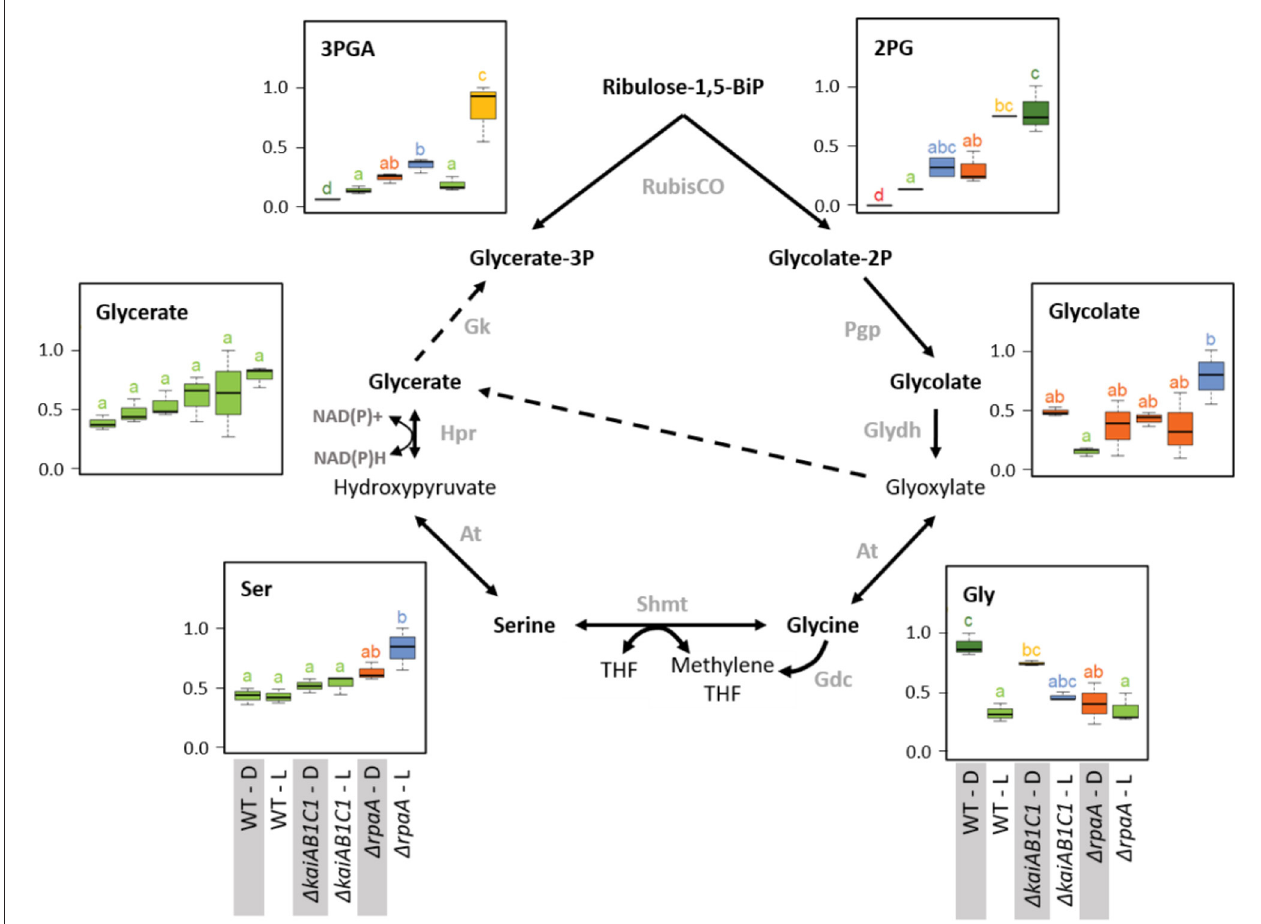
FIGURE 7 | Photorespiration. Box plots showing the maximum normalized relative changes in the metabolite concentrations and Tukey test results ( P < 0.05, n = 3). Metabolite levels that significantly differ are indicated by lowercase letters and color coding. Note the moderate and strong increases in the RubisCO products 3PGA and 2PG in the 1 kaiAB1C1 mutant and the 1 rpaA mutant, respectively. High 2PG accumulation in the 1 rpaA mutant continues in the D phase and is associated with glycolate accumulation in the L phase. Serine and glycine respond inversely to RpaA deficiency. Glycine fails to accumulate in the D, while serine accumulates in the L. Dashed arrows indicate multiple reaction steps. Relevant enzymes and complexes include (gray) glycolate-2P phosphatase (Pgp), glycolate dehydrogenase (Glydh), aminotransferase (At), glycine decarboxylase complex (Gdc), serine hydroxymethyltransferase (Shmt), tetrahydrofolate (THF), hydroxypyruvate reductase (Hpr), and glycerate kinase (Gk).